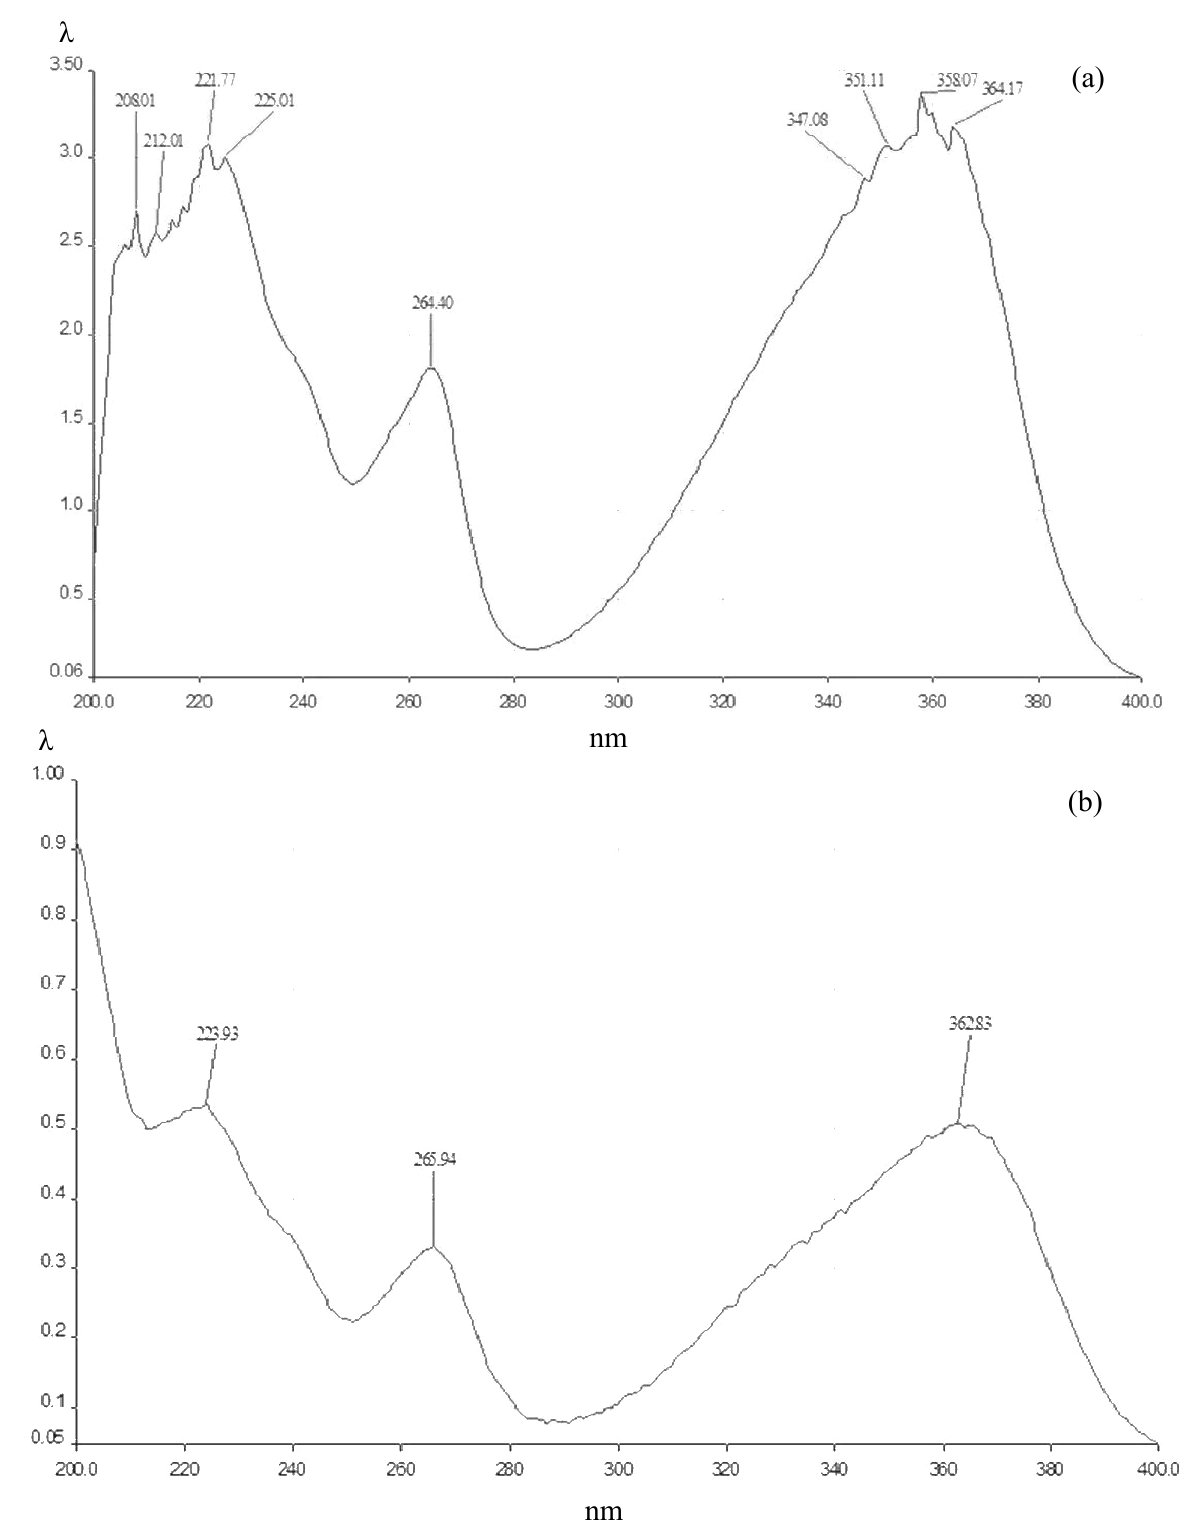
Figure 2. UV spectrum of the crystals formed by aflatoxin B (b). The λ values in the ordinate of (a) vary from 0.06 to 3.50, the corresponding to AFB 1 in (b) the values are from 0.06 to 1.00. The maximum peaks in (a) (224, 266, and 363 nm) show a correspondence with the detected in (b) (222, 264, and 358